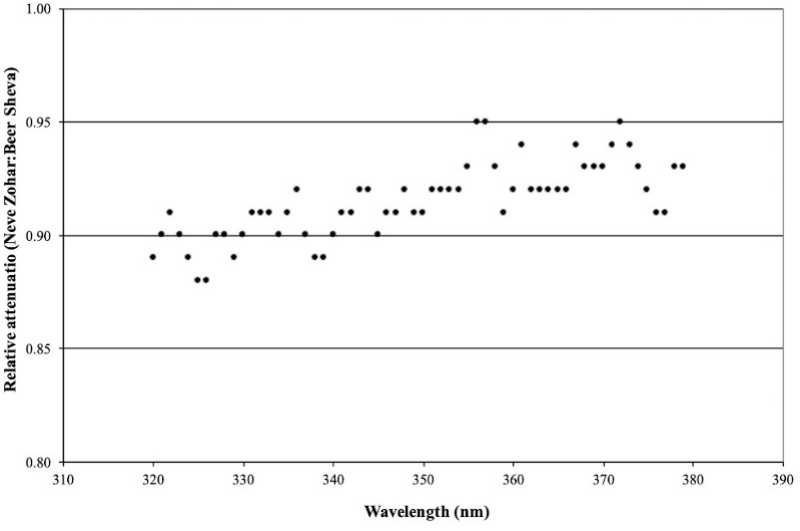
Figure 3. Relative UVA irradiation attenuation within its spectral range: (Neve Zohar:Beer Sheva).